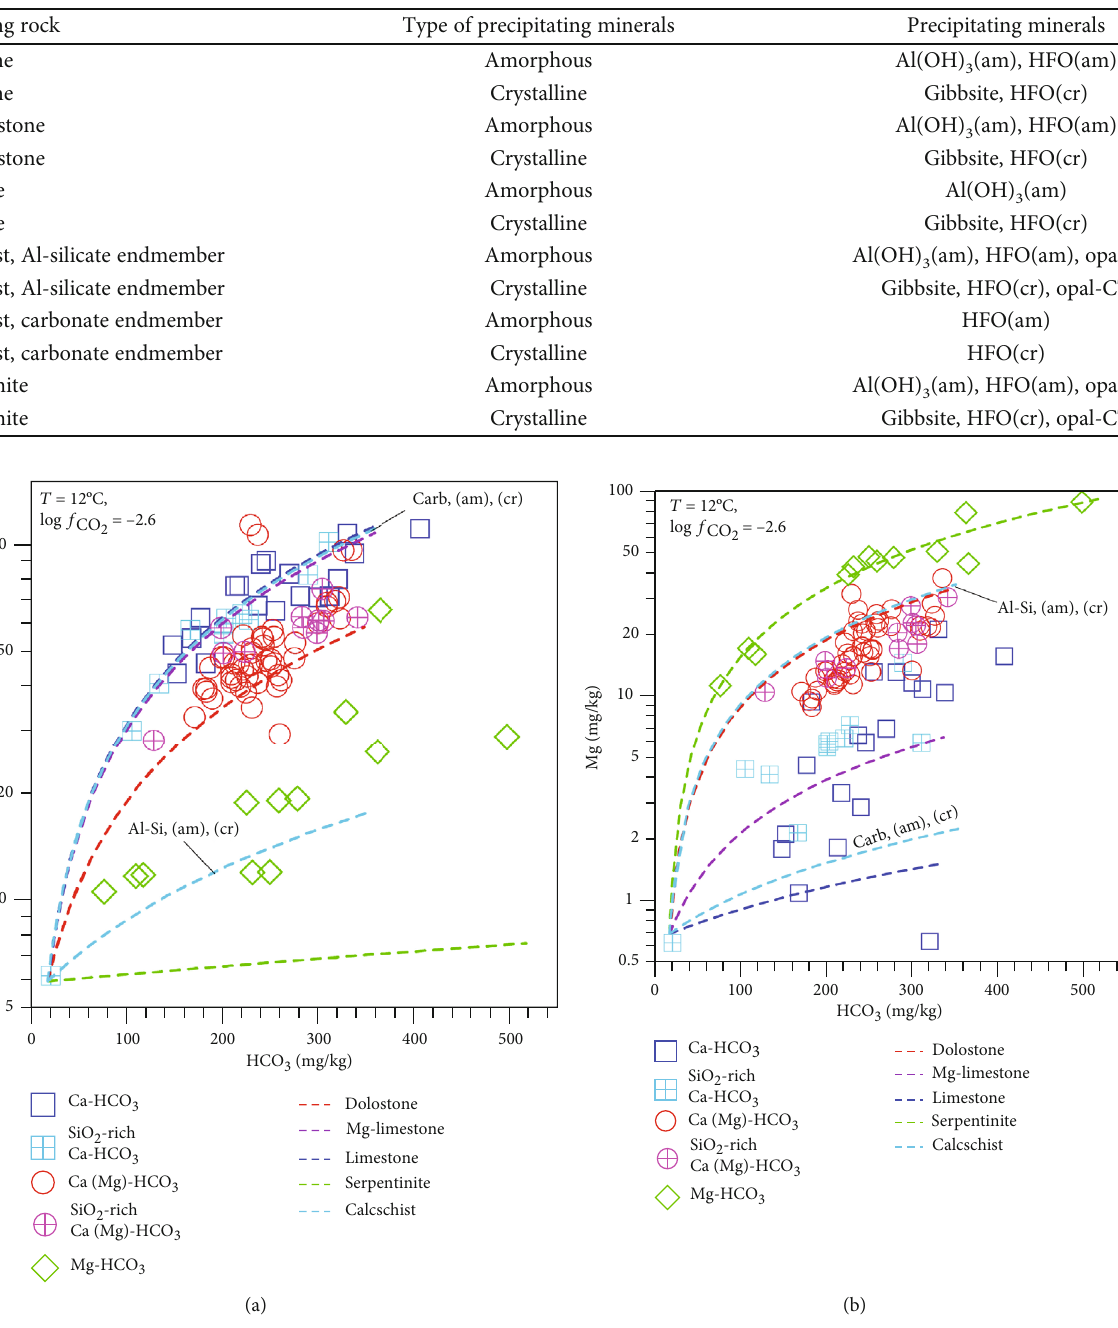
/kg) vs. (a) calcium and (b) magnesium during the progressive 3